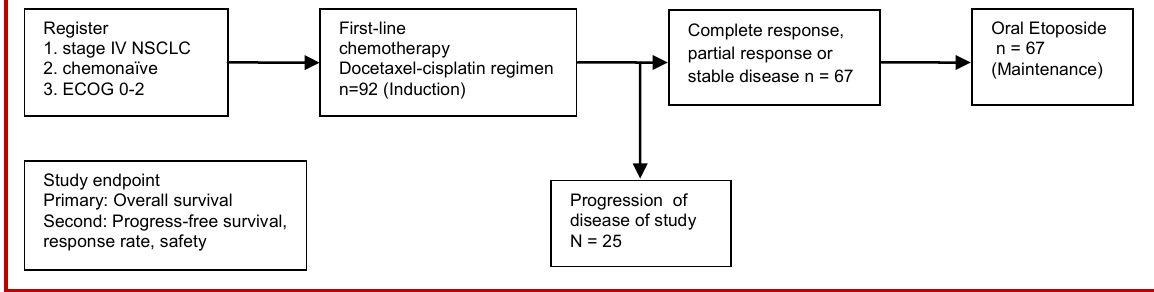
Figure 1: Diagram of study. Docetaxel/cisplatin. docetaxel (75 mg/m 2 , day 1) plus cisplatin (75 mg/m 2 , day 1). After 4 cycles of induction treatment, patients without progression of disease received oral etoposide for maintenance